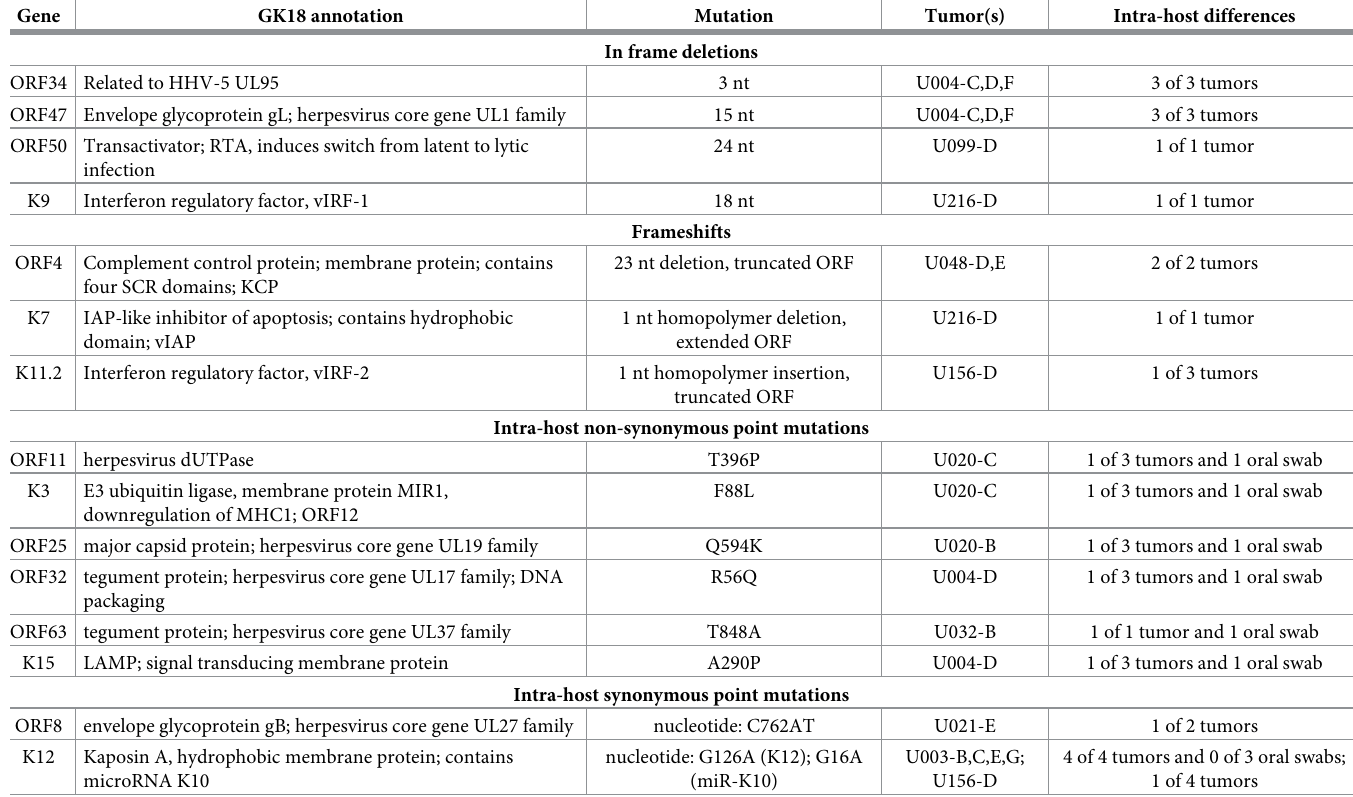
Table 4. Coding sequence mutations, excluding those in K8.1, K4.2 and K11.2 and rearrangement